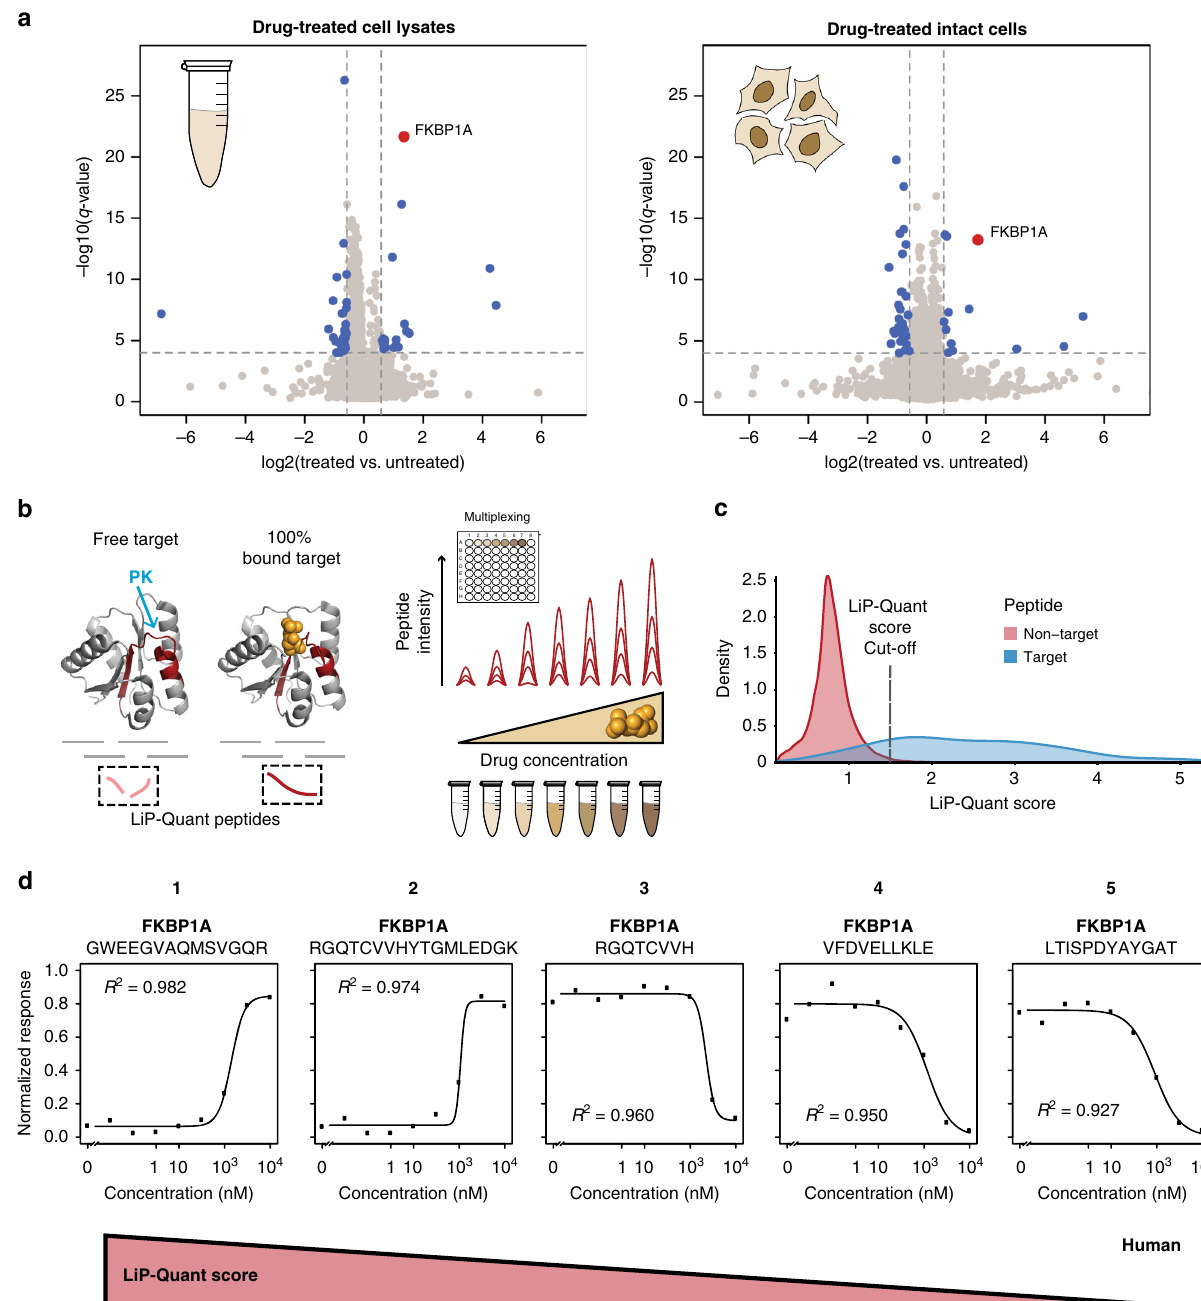
Fig. 1 LiP-Quant, a platform for drug target identi fi cation. a Volcano plots of LiP samples from HeLa lysates (left panel, n = 4 of independent lysate replicates) and live HeLa cells (right panel, n = 3 of biologically independent cells) treated with rapamycin. Peptide mixes produced in the presence or absence of 2 µ M rapamycin are compared. Fold changes (FC) in peptide abundance for treated and untreated samples are shown as a function of statistical signi fi cance. Signi fi cance cutoffs were q -value = 0.0001 ( t -test, one sample, two-tailed) and FC = 1.5. Each protein is represented with a single data point, corresponding to the peptide with the lowest q -value. The known interactor of rapamycin (FKBP1A) is highlighted in red. Proteins passing both cutoffs are in blue. b Principle and experimental design of LiP-Quant. Sample preparation for MS analysis follows a multiplexed work fl ow that is suitable for the processing of drug libraries. c Compiled LiP-Quant score distributions (Gaussian smoothed kernel density) for known target and non-target proteins from all HeLa experiments with the exception of the promiscuous binder staurosporine. d Dose – response curves showing relative intensities of LiP-Quant peptides after partial proteolytic digestion of aliquots of HeLa lysates over a rapamycin concentration range. Curves of the top 5 LiP-Quant peptides ranked by LiP-Quant score, all of which are from the expected direct target FKBP1A, are shown. The numbers on top of the graph show the LiP-Quant score position of the relative peptides. Source data are provided as a Source Data fi